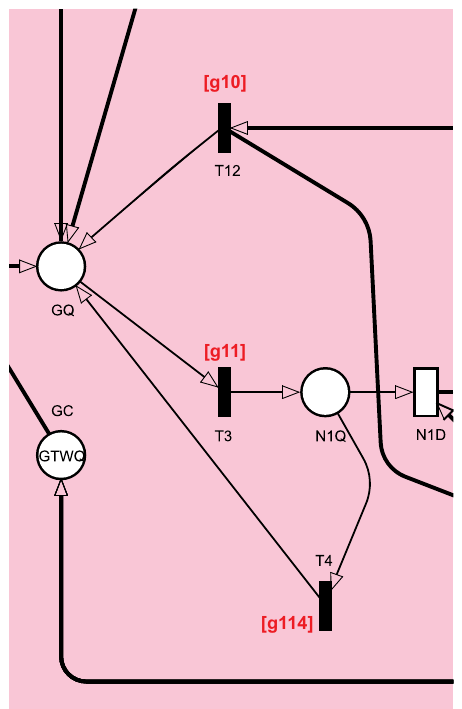
Figure 5. Gateway submodule responsible for transmitting requests to the final processing